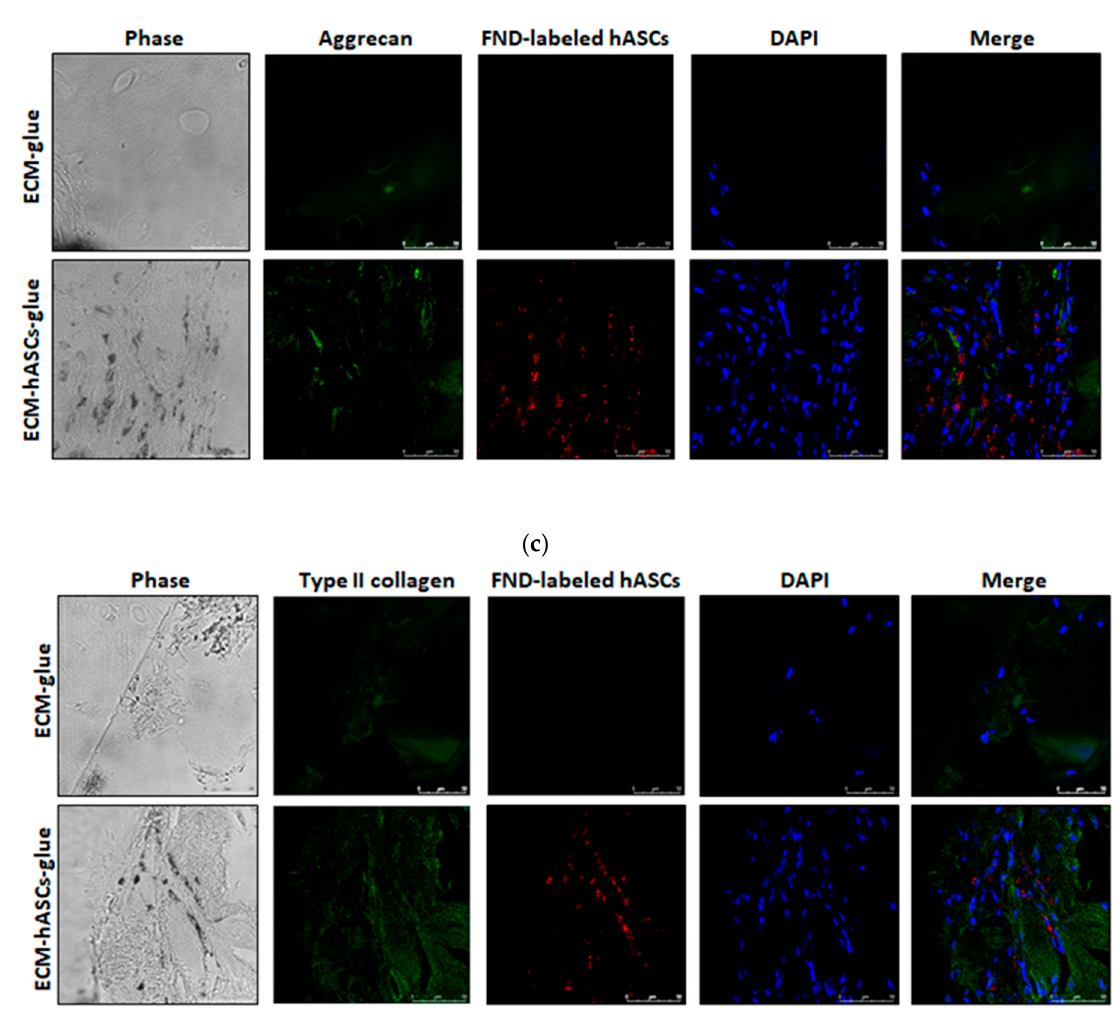
Figure 5. Functional in vivo chondrogenesis of hASCs. ( a ) The presence of glycosaminoglycans and collagen demonstrated chondrogenic differentiation by Alcian Blue and Masson’s Thrichrome staining, separately. Alcian Blue, Nuclear Fast Red, and Masson’s Thrichrome staining of the xenografts from ECM-hASCs-glue and ECM-glue groups three months afterwards. Upper panel represents the ECM-glue group. Lower panel represents the ECM-hASCs-glue group. Masson’s Trichrome staining of the ECM-hASCs-glue and ECM-glue groups after three months implantation (Original magnification × 200). (Arrows indicate the interstitial spaces.) ( b ) Immunofluorescent staining for Aggrecan for identifying glycosaminoglycan (green) and FND-labeled hASCs (red) in ECM-hASCs-glue and ECM-glue groups. ( c ) Fluorescence imaging of type II collagen (green) were presented in ECM-hASCs-glue and ECM-glue groups. Scale bar: 50 μ m.